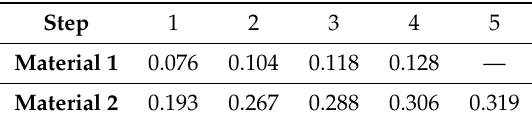
Table 2. Steps used for the damage evolution analysis with the specimens of both